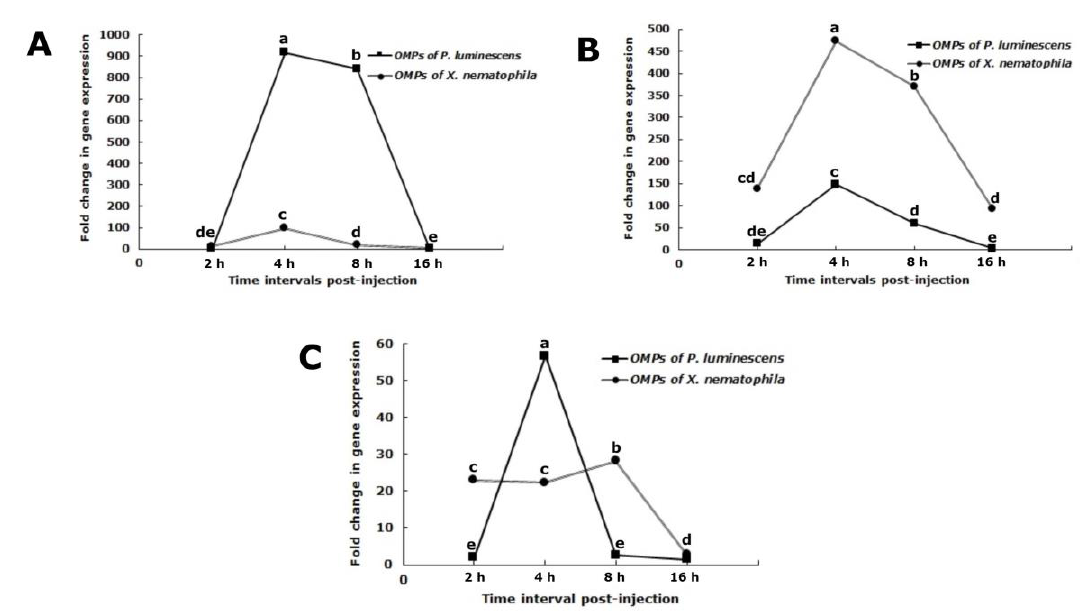
Figure 4. Changes in the patterns of the expression of selected inducible antimicrobial genes in fifth instar larvae of Spodoptera exigua after injection with outer membrane proteins of Xenorhabdus nematophila or outer membrane proteins of Photorhabdus luminescens , ( A ) attacin, ( B ) cecropin, ( C ) spodoptericin. Each measurement consists of eight replications. The vertical bars represent the standard deviations of the means. Di ff erent letters above the error bars indicate a significant di ff erence of interactive e ff ect means between outer membrane proteins types × interval times at α = 0.05 (Slicing